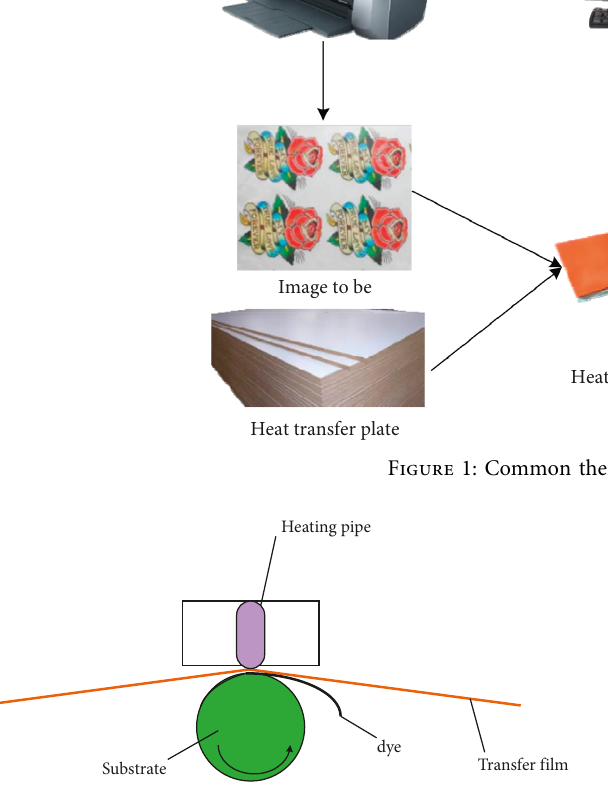
Figure 2: The working principle of thermal transfer.